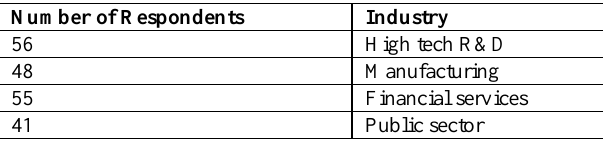
Table 1: The sample for the quantitative study Number of Respondents Industry